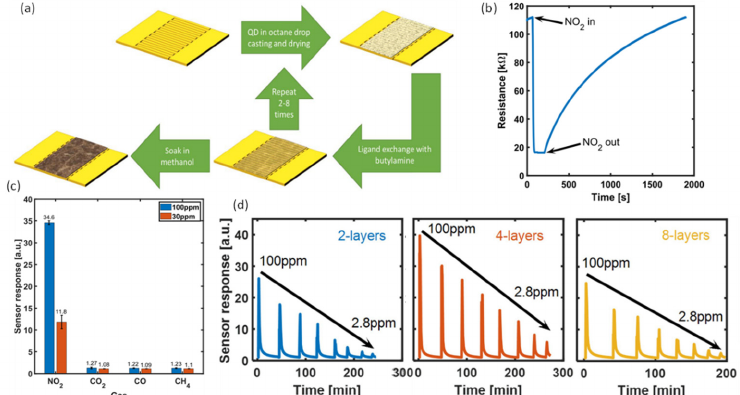
Figure 7. PbS-dispersed colloidal QD sensor for NO 2 detection at RT. ( a ) Device fabrication process. ( b ) Signal response to 30 ppm of NO 2 . ( c ) Selectivity of the device against other pollutants. ( d ) Effect of film thickness on the performance of the sensor. Adapted with permission from [51]. Copyright by Nature Publishing Group